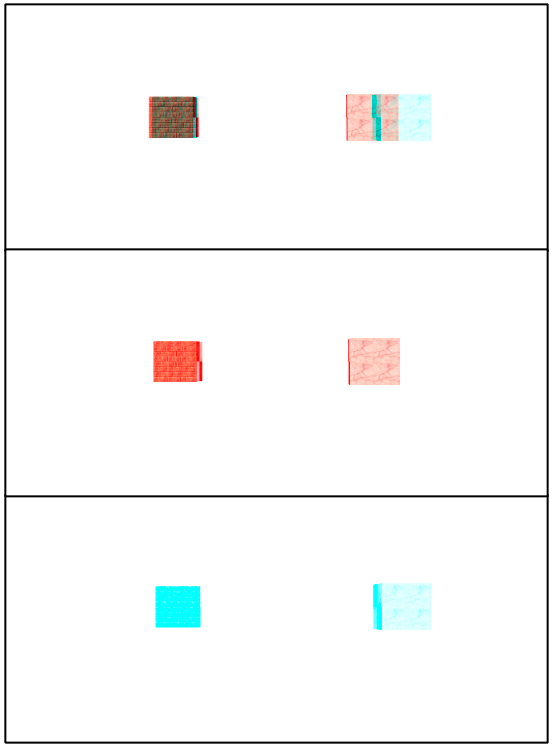
Figure 1. A stereogram used in the present study. ( top ) Two cubes were rendered in cross disparity such that, when viewed with red-blue anaglyph glasses, both appear floating in front of the monitor. The cube on the right appears closer to the observer; ( middle ) half image for the right eye; ( bottom ) half image for the left eye.